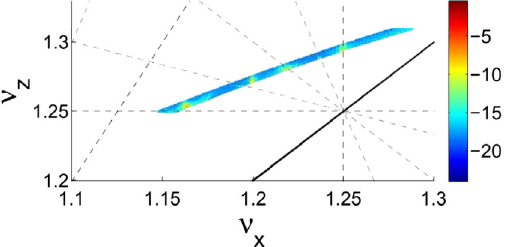
FIG. 7. The tune footprint of particles uniformly distributed in the effective vacuum chamber. The momentum spread is set ¼ − 3 . 0% and þ 3 . 0% . The color bar stands for the between δ p þ Δ ν 2 Þ . There is no tune diffusion rate, defined as log 10 ð Δ ν 2 x y particle loss in the tracking. Both tune spread and diffusion rate are